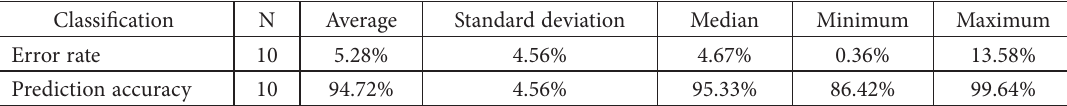
Table 15. Descriptive statistics of the error rate and prediction accuracy of the prediction model